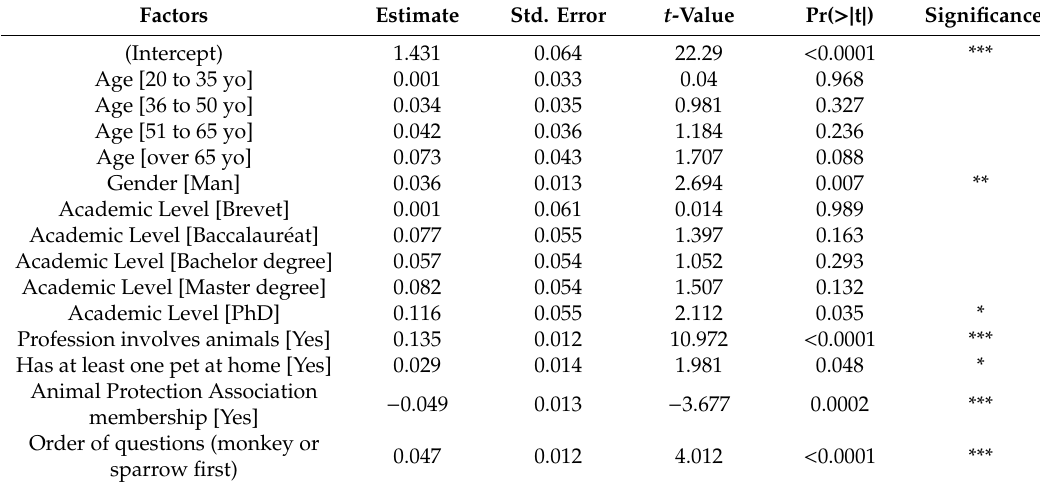
Table 2. Statistical values for the GLM with the Biological Reality Score as response variable. For Age, indicated factors are compared with Age [less than 20 yo]. For Gender, ‘man’ is compared to ‘woman’. For academic level, factors are compared to [Without diploma]. For the remaining questions [Yes] is compared to [No]. For the estimate and the t -value, a positive value indicates a positive influence of the factor; a negative value indicates a negative influence. Significance: * < 0.05, ** < 0.01, *** < 0.001.